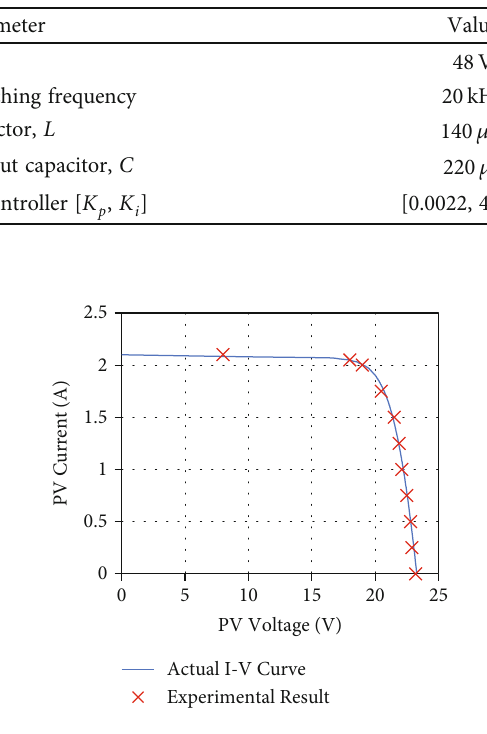
Figure 16: I-V characteristics obtained from experimental setup of PVE.